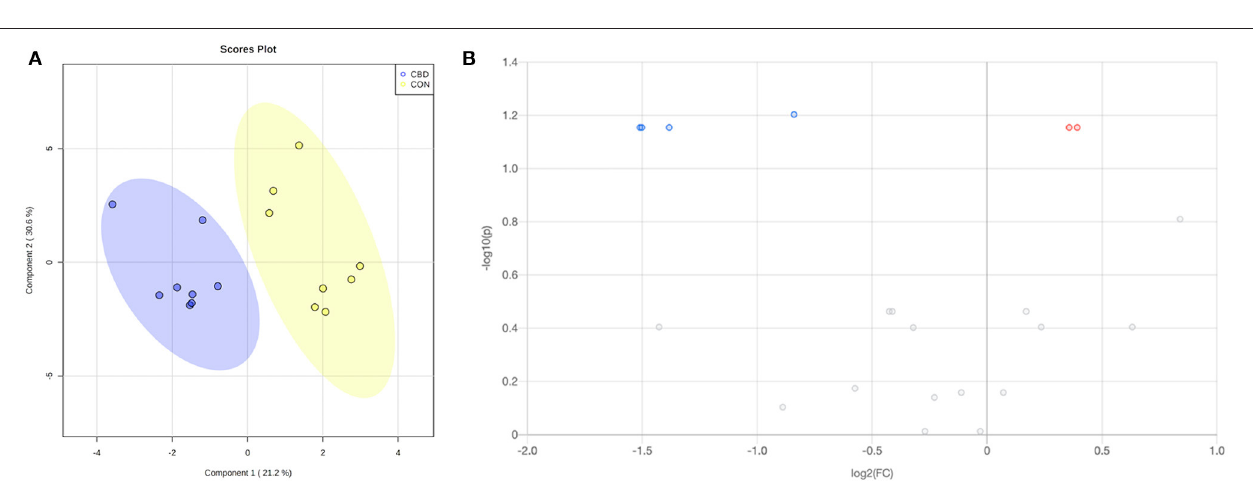
FIGURE 2 | (AUROC = 0.95; P = 0.004); (N) ascorbate (AUROC = 0.95; P = 0.003); (O) D-lysopine (AUROC = 0.95; P = 0.004); (P) o -tyrosine (AUROC = 0.95; P = 0.001); (Q) phenylalanyl-glycine (AUROC = 0.95; P = 0.002); (R) 2,4-dihydroxyhept-2-enedioate (AUROC = 0.94; P < 0.001); (S) asparaginyl-aspartic acid